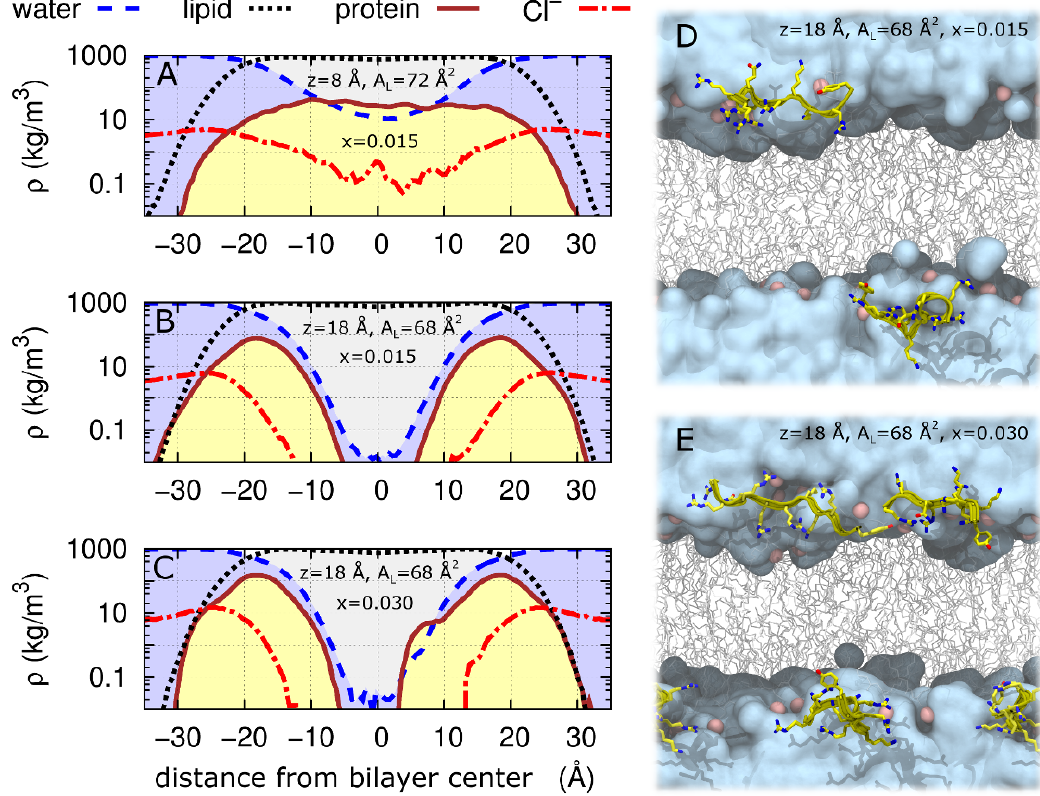
Figure 8. Log scale of mass densities along the DOPC:DOPE (1:1) bilayer normal and snapshots of peptide insertion into the bilayer headgroup region. ( A – C ) Average mass density, ρ , of water (dashed blue line), lipid (dotted black line), protein (solid brown line), and Cl − (dash-dot red line) as a function of distance from bilayer center (Å). Simulations restricted to χ 2 < 3.4 are shown: ( A ) averages of the 10 (of N = 52) simulations at z = 8 Å, A L = 72 Å 2 and a Tat 47–57 mole fraction of 0.015; ( B ) all N = 52 simulations at z = 18 Å, A L = 68 Å 2 and a Tat 47–57 mole fraction of 0.015; and ( C ) both N = 2 simulations at z = 18 Å, A L = 68 Å 2 and a Tat 47–57 mole fraction of 0.030. Snapshots after 100 ns of simulation at z = 18 Å, A L = 68 Å 2 and a Tat 47–57 mole fraction of ( D ) 0.015 or ( E ) 0.030. Water is cyan, lipids are gray, lipid headgroup phosphorus atoms are pink, and protein is yellow. Protein is rendered in front of all other molecules for